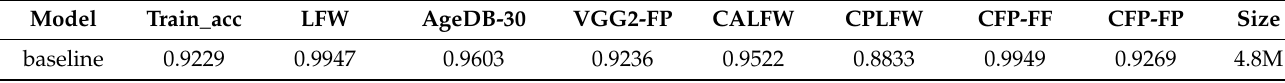
Figure 7. The best threshold of the baseline on LFW during the training stage. Table 3. The test results of the baseline. The data in the columns of LFW, AgeDB-30, VGG2-FP, CALFW, CPLFW, CFP-FF, and CFP-FP represent the accuracy of the model on different test sets. These test sets are described in detail in Section 4.1.